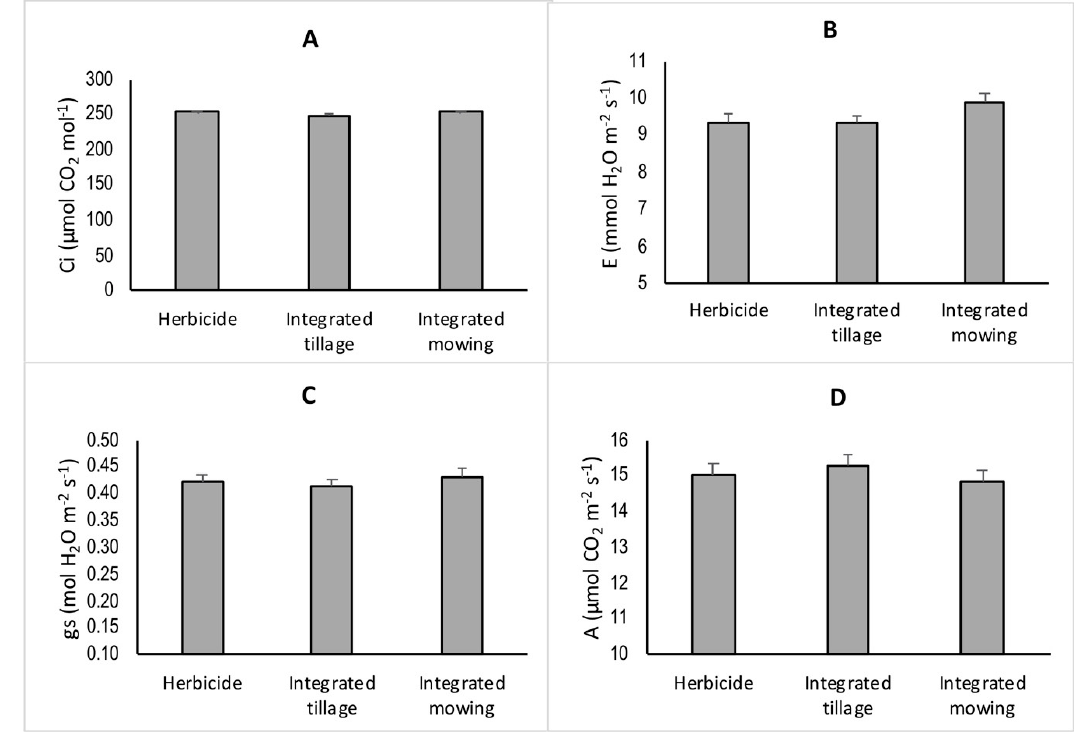
Figure 2. Effects of integrated weed management on different gas exchanges: ( A ) intercellular CO 2 concentration (Ci), ( B ) transpiration rate (E), ( C ) stomatal conductance (g s ), and ( D ) net photosynthetic rate ( A ) in leaves of apple and peach trees. Bars represent standard error.